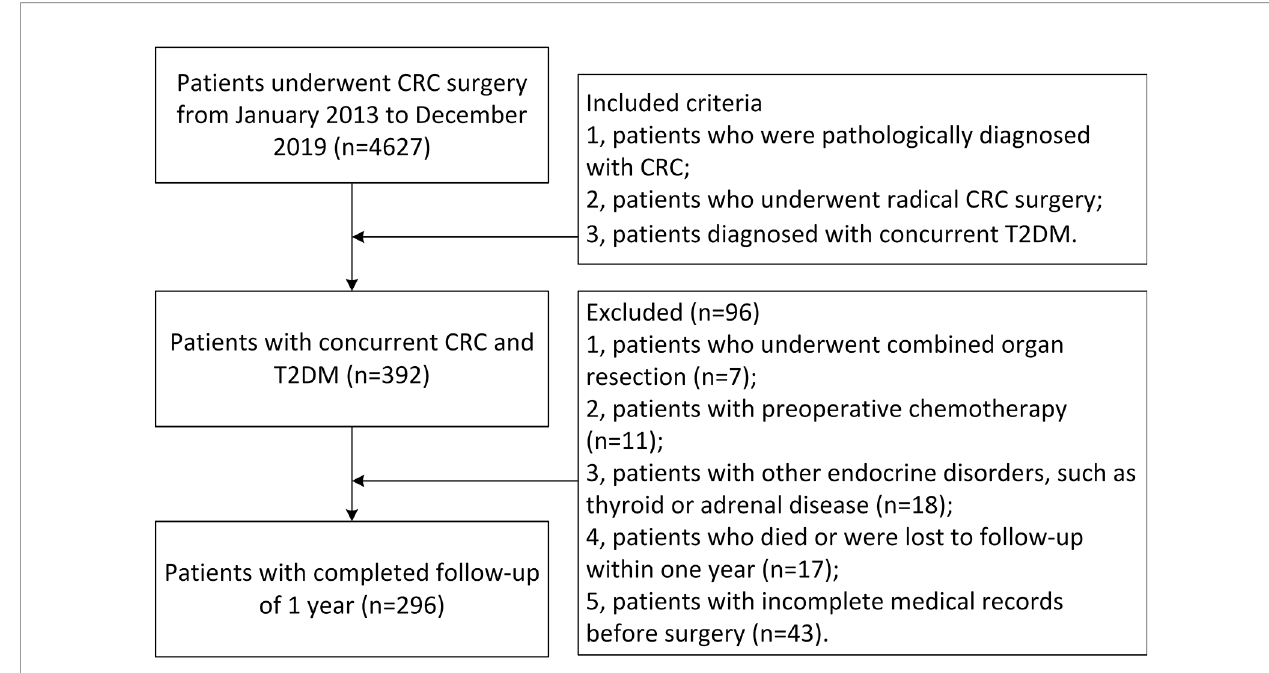
FIGURE 1 | Inclusion and exclusion criteria of patients with concurrent CRC and T2DM. CRC, colorectal cancer; T2DM, type 2 diabetes